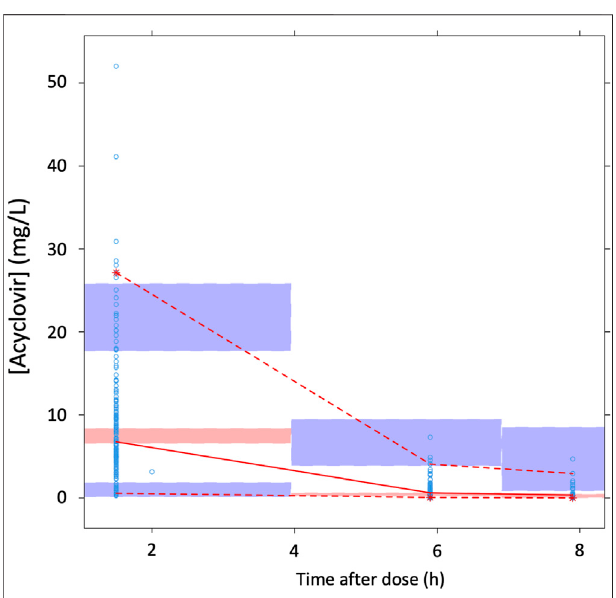
FIGURE 4 | The prediction-corrected visual predictive check based on the present data. Open circles, individual plasma concentrations of acyclovir together with their median and 5th-95th percentiles (solid and dashed red lines, respectively). The 95% con fi dence intervals of the simulated median (pale pink) and 5th-95th percentiles (pale blue) are